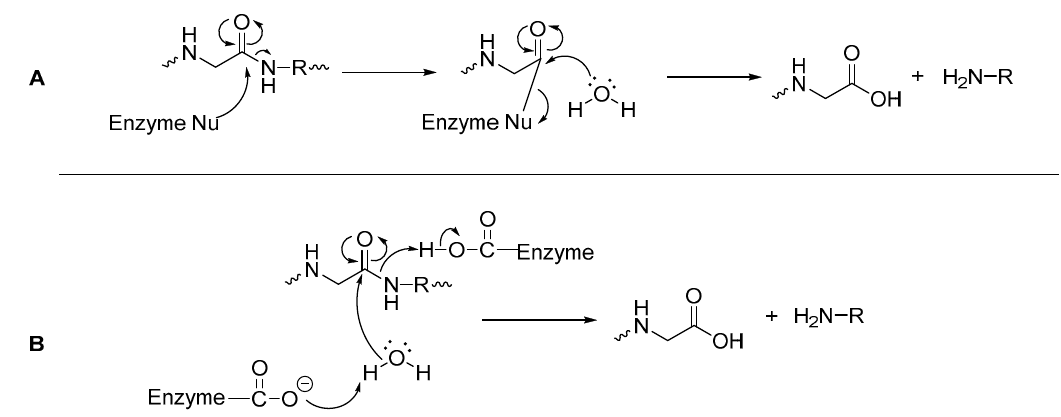
Figure 3. General mechanisms of hydrolysis via a peptidase ( A ) with nucleophilic amino acids; ( B ) with acidic amino acid residues [43,44].